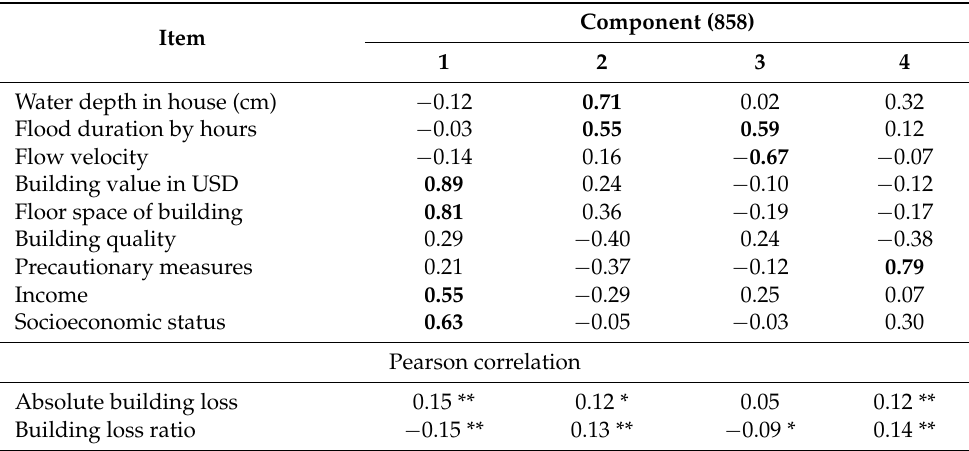
Table 9. Component loading variables that probably influence building losses.